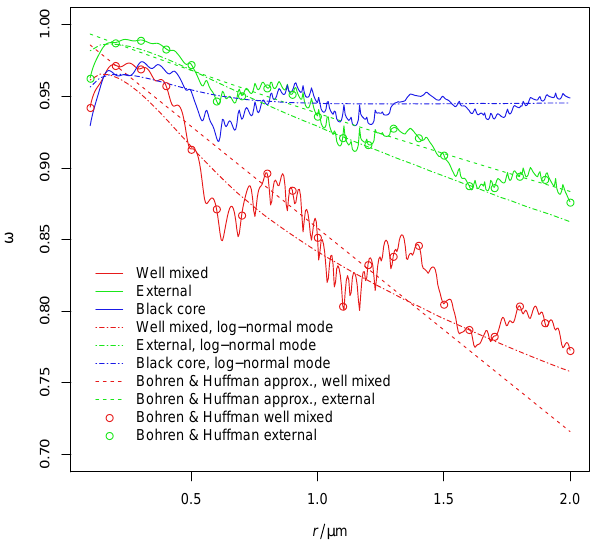
Figure 2. The single-scattering albedo of a mixture of a “black” component ( m = 1 . 7 + i 0 . 7, 1% of the particle volume) and a “white” component ( m = 1 . 55 + i 10 − 6 , 99% of the particle vol- ume), assuming homogeneous internal mixing (red), external mix- ing (green) and core-shell particles (blue). The abscissa denotes the radius of the internally mixed particles and, in the case of the ex- ternal mixture, the white particles; the radius of the black parti- cles is 0 . 05 µm. The results have been calculated using our new SCATTNLAY-based AEROPT mixing algorithm for single size par- ticles (solid) and log-normal size distributions ( σ g = 1 . 59, dash- dotted). In the latter case, average mass radii are used. Also shown are analytic approximations (dashed) and numeric results (circles) from Bohren and Huffman (2007) for homogeneous internal and external mixtures. The wavelength is 0 . 55